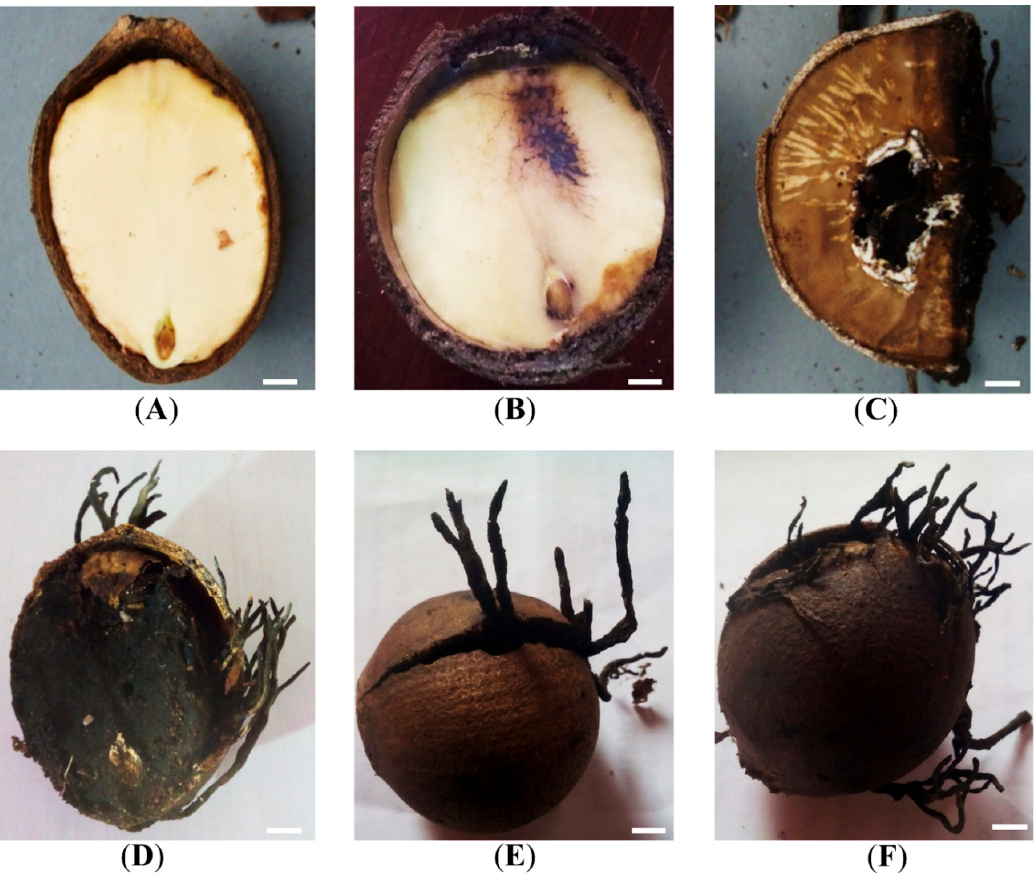
Figure 1. Symptoms of Xylaria karyophthora on Chlorocardium spp. (Lauraceae) seeds from Guyana. ( A ) Healthy seed; ( B , C ) Early stages of infection; ( D – F ) Stromata of Xylaria on Greenheart seeds. Bar = 10 mm.